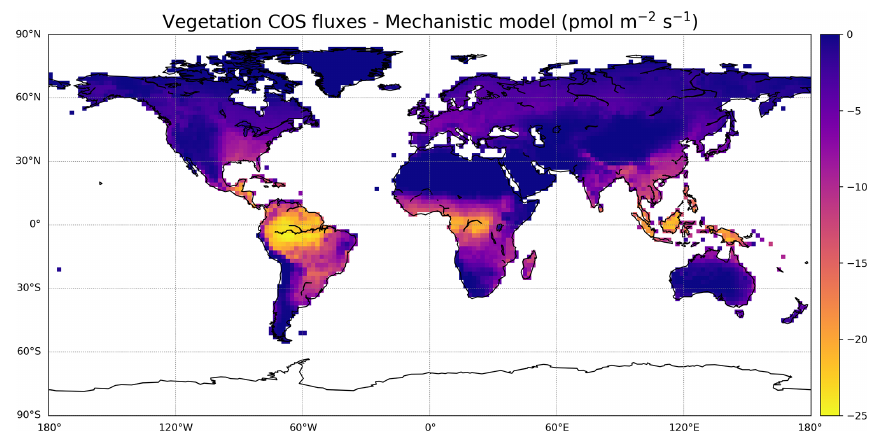
Figure 5. Map of average vegetation COS fluxes over the 2000–2009 period, from the mechanistic model as implemented in ORCHIDEE. Table 5. Overview of COS plant uptake per year (GgSyr − 1 ). Kettle et al. Montzka et al. Suntharalingam Berry et al. Launois et al. (2015b) This study (2002) (2007) et al. (2008) (2013) ORC. LPJ CLM4 Period study circa